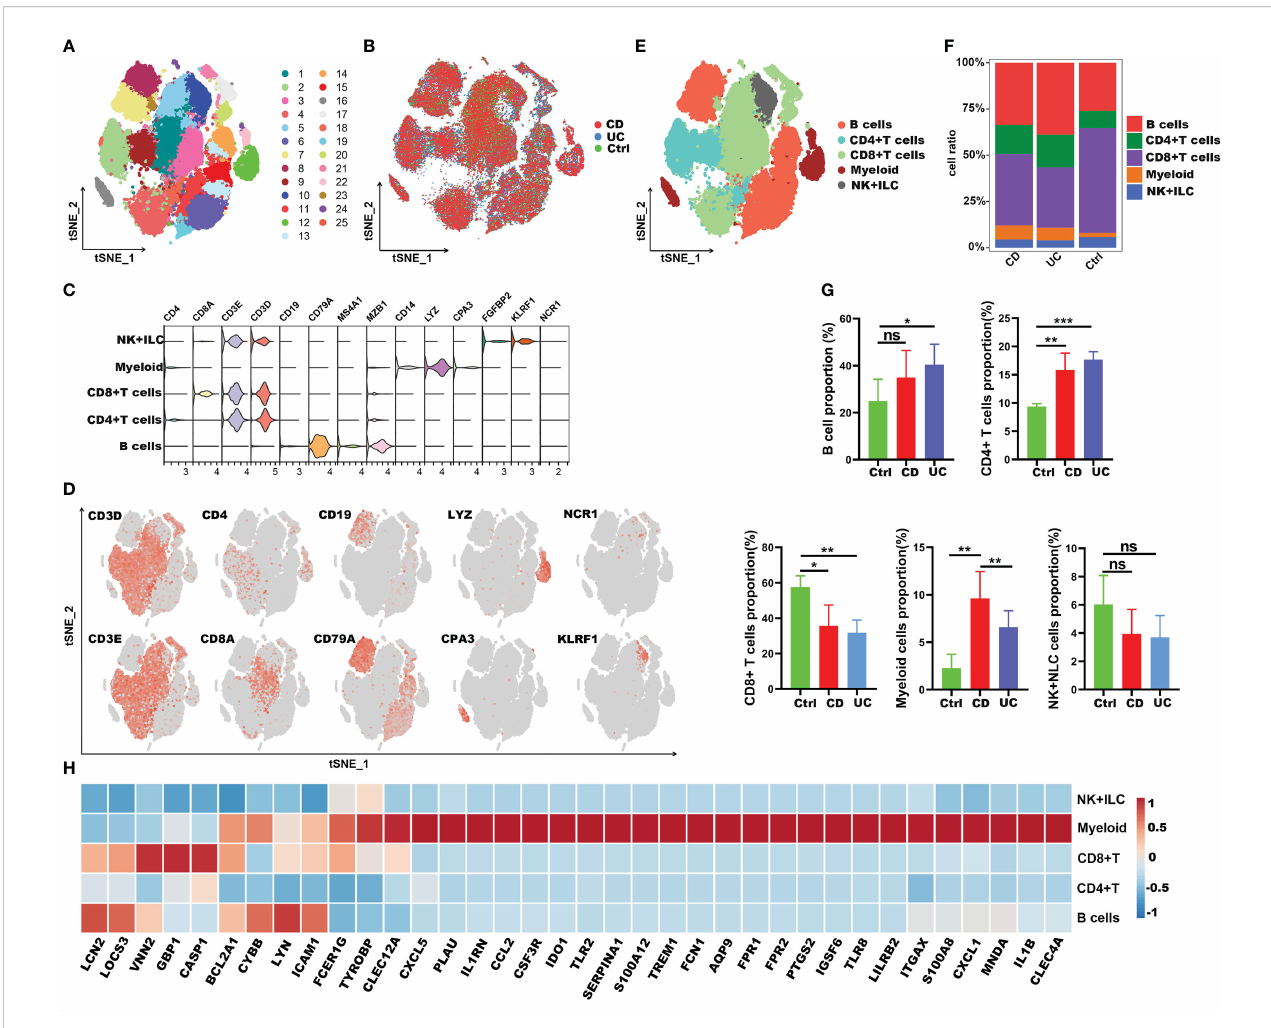
FIGURE 7 Immune landscape of the IRGs at the single-cell resolution in CD45 + immune cells of IBD. (A, B) t-SNE plot displaying 63,314 immune cells in IBD and healthy controls; color denotes cluster origin (A) and sample origin (B) . (C) Violin plots showing expression levels of speci fi c markers for NK+ILC, myeloid cells, CD8 + T and CD4 + T cells. (D) t-SNE plot demonstrating the expression of marker genes in different cell types. (E) t-SNE plot representation of the major cell types of CD45 + immune cells in IBD patients. (F) Proportion of each cell types in IBD patients and healthy controls. (G) Bar plots showing the relative frequencies of each cell types in IBD and healthy controls. (H) Heatmap showing the expression patterns of IRGs in major cell types. * p < 0.05; ** p < 0.01; *** p < 0.001; ns, not signi fi